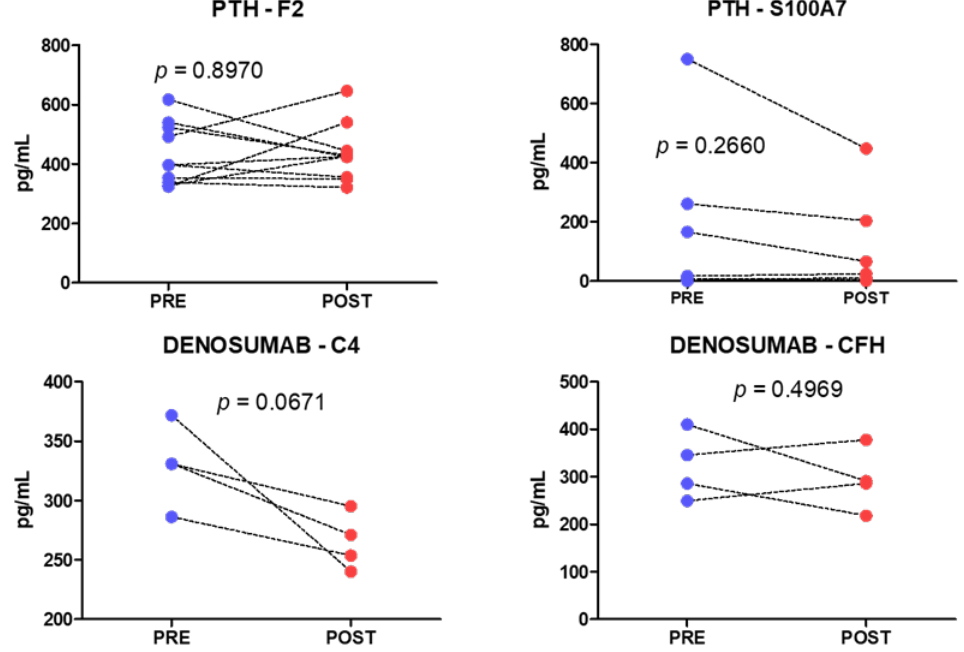
Figure 7. Serum levels of individual proteins in patients treated with teriparatide ( above ) or deno-